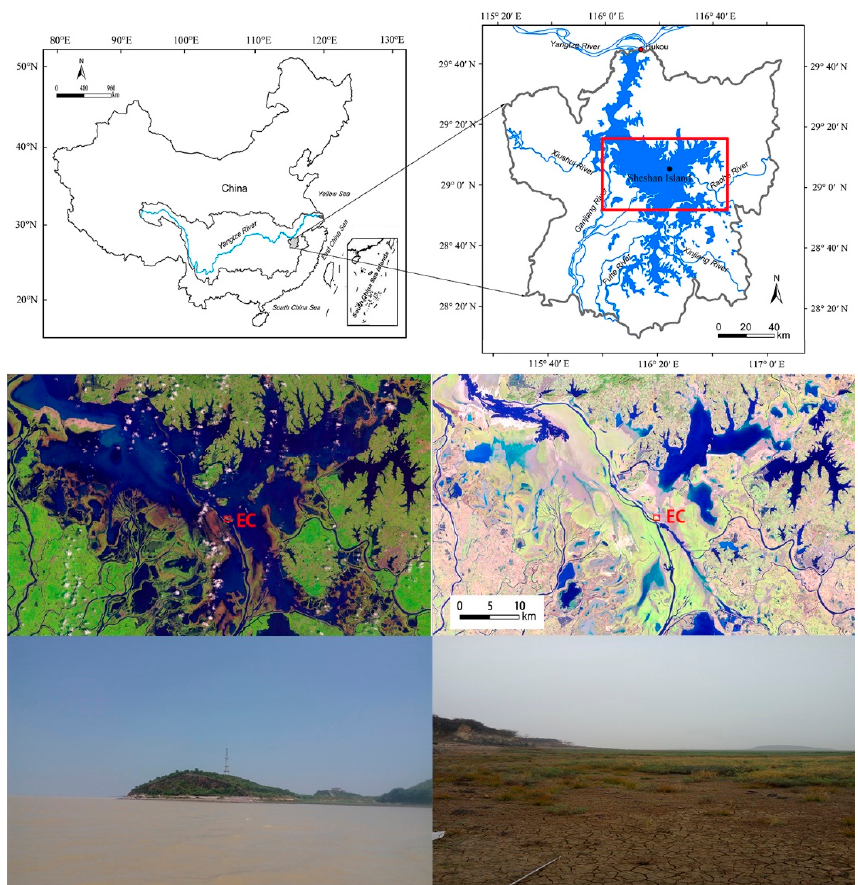
Figure 1. The extent of Poyang Lake and the measuring site in Sheshan Island. The middle panel shows the Landsat 8 images (composites using bands 5, 4, and 3 of the Operational Land Imager, which emphasize the distribution of the water body and vegetation) acquired on 24 August (high-water) and 13 February (low-water). The lower panel shows pictures of the measuring site during the high-water and low-water periods.